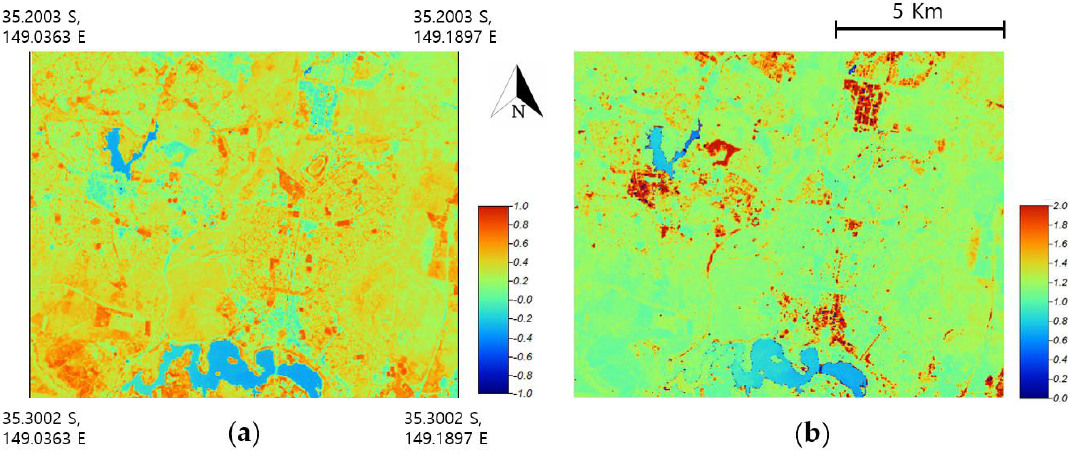
Figure 6. Vegetation indices obtained from the surface reflectance product of Landsat-8 in the Google Earth Engine (GEE): ( a ) Atmospherically Resistant Vegetation Index (ARVI); ( b ) Structure Insensitive Pigment Index (SIPI).